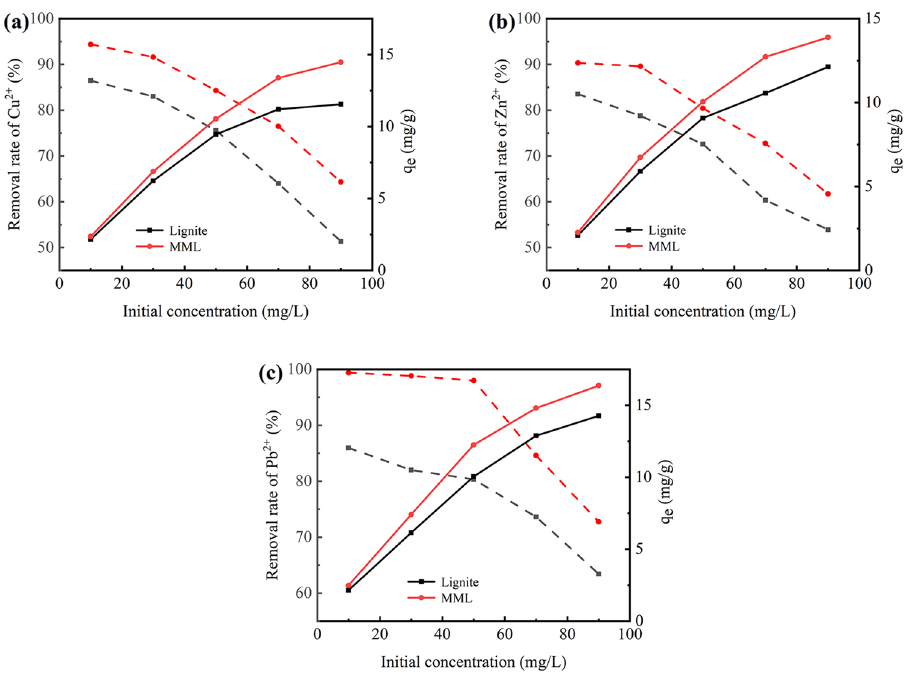
Figure 2. Relationship between initial concentration of heavy metal ions and adsorption effect: ( a ) Cu 2+ removal effect; ( b ) Zn 2+ removal effect; ( c ) Pb 2+ removal